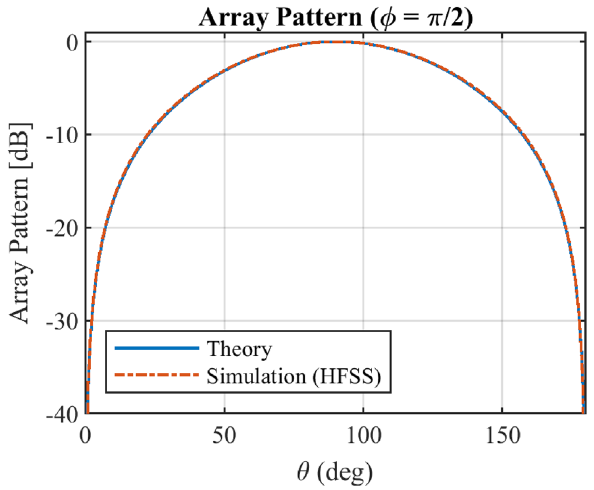
Figure 11. The total radiation pattern of array at φ = π/2 including the mutual coupling effect considered in simulation study by HFSS.